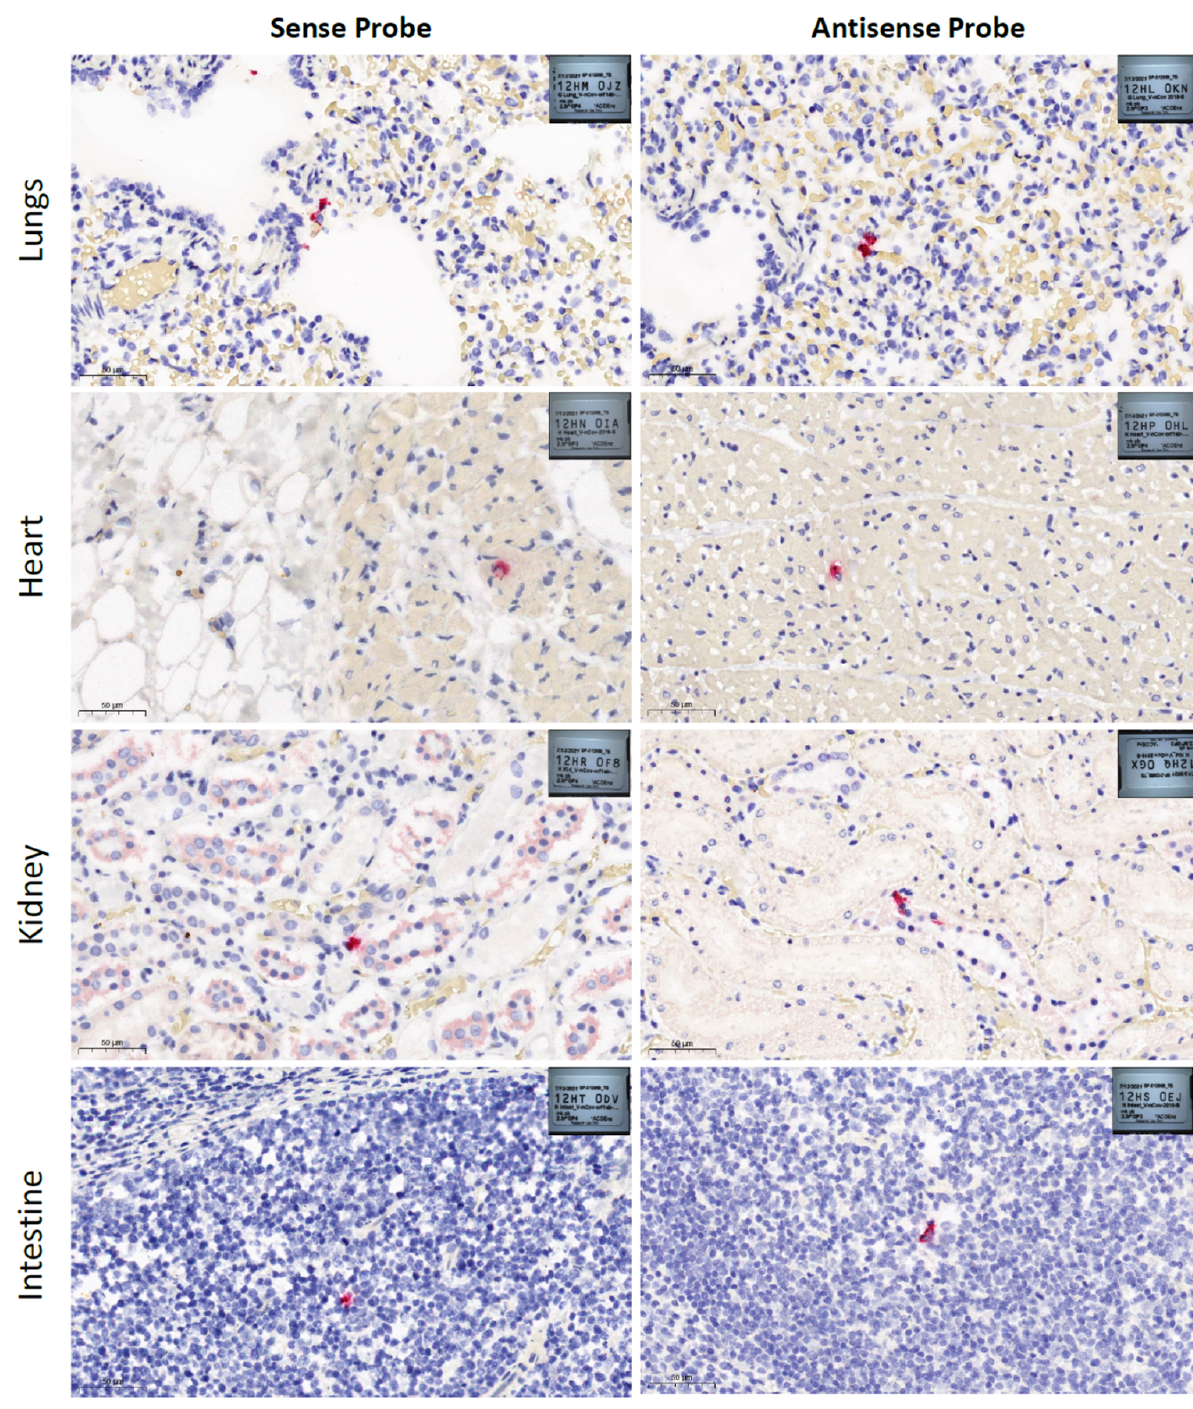
Figure 1. SARS-CoV-2 RNA in situ hybridization (ISH) images generated from RNAscope LS RED Singleplex ISH assays performed in formalin-fixed-paraffin-embedded (FFPE) canine tissue samples using RNAscope ® 2.5 LS Probe-V-nCoV2019-S and RNAscope ® 2.5 LS Probe-V-nCoV2019-orf1ab-sense (Advanced Cell Diagnostics, Bio-Techne, Minneapolis, MN, USA). Sections of lungs, heart, kidney, and intestine from a SARS-CoV-2 exposed dog showing red staining that represent RNAscope probes hybridized with SARS-CoV-2 positive (sense) and negative (antisense) RNA. Lungs presented marked pulmonary congestion and edema, moderate fibrin in alveoli, desquamated pneumocytes, and hyaline membranes. Heart presented epicardial edema and mild interstitial hemorrhage. No pathological changes were observed in kidneys or intestines. Hematoxylin and eosin staining, scale bars 50 µ m. Images were generated with SlideViewer 2.5.0.143918 soft-